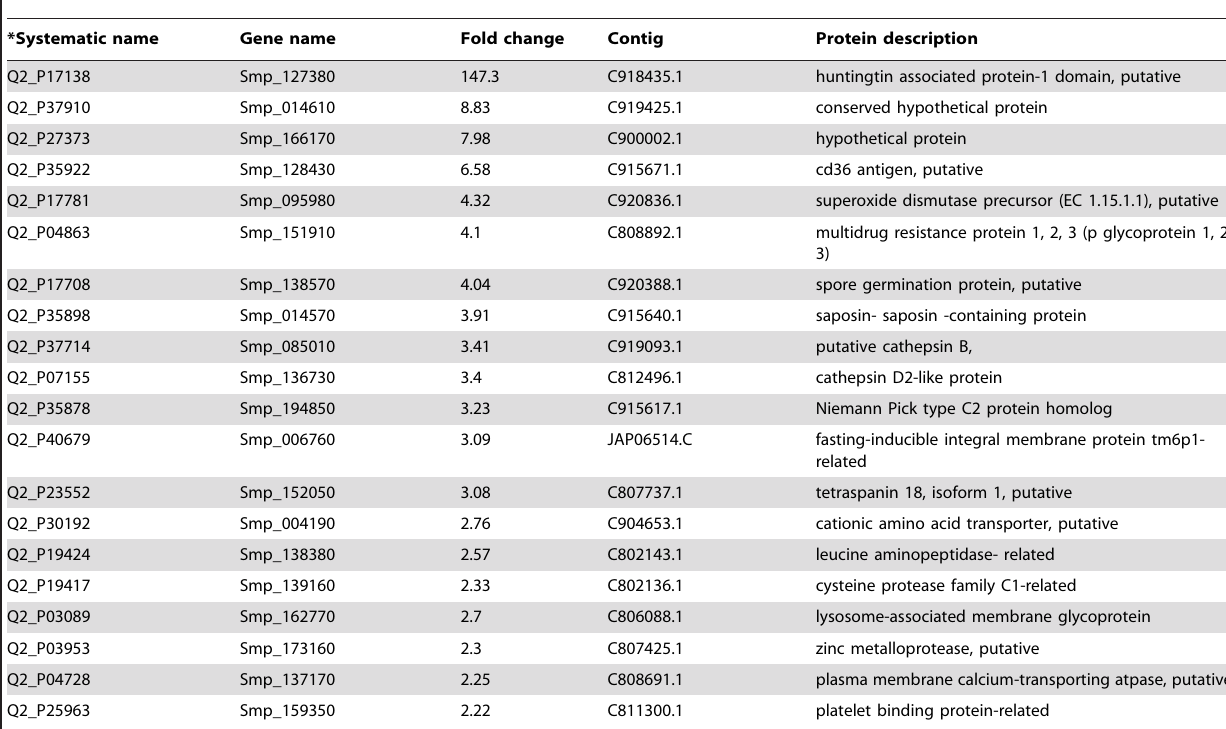
Table 1. A selection of differentially up-regulated genes of the female gastrodermis normalised to the whole female control.